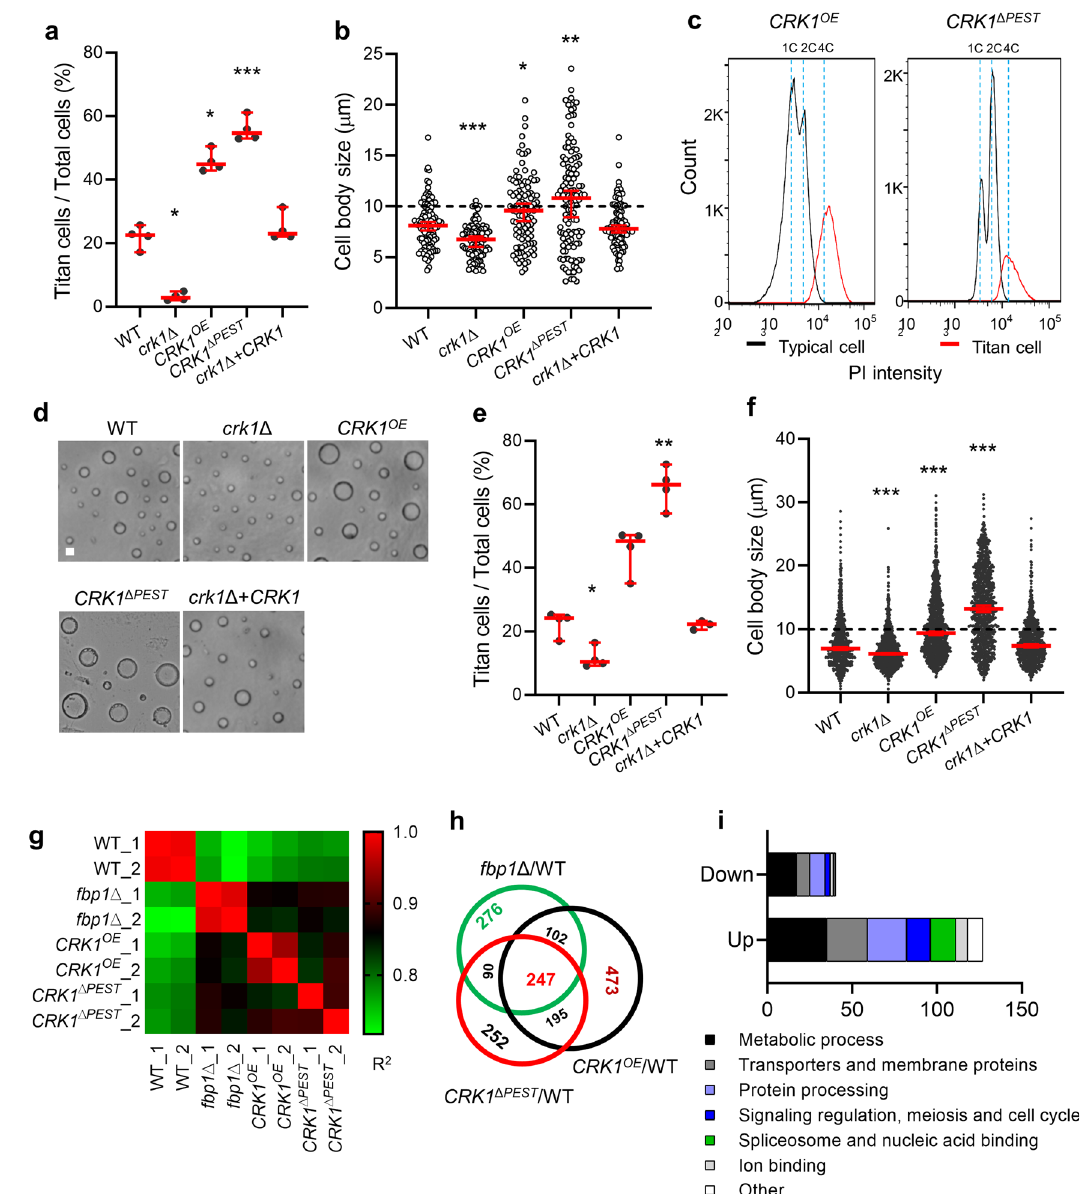
Fig. 3 | Deletion of Fbp1 increases the proportion of titan cells through Crk1 protein accumulation. a , b Quantitative measurement of titan cell proportion ( a ) and cell size ( b ) under in vitro titan cell inducing conditions. The titan cell per- centage data are cumulative from four independent experiments and the cell size data ( n =100 cells) are representative of four independent experiments. Error bar indicates95%con fi denceintervalof themedian. Statistical analysis wasperformed with the two-sided Kruskal-Wallis nonparametric test for multiple comparisons. * P =0.05; 0.03; *** P =0.0004 in panel ( a ). * P =0.01; ** P =0.001; *** P <0.0001 in panel ( b ). c FACS analysis of DNA content in the CRK1 OE and the CRK1 Δ PEST strains. Cells were fi xed and stained by propidium iodide (PI) after 3 days of incubation in titan cell inducing conditions. The population of large cells showed increased PI fl uorescenceintensityto>2C,whilethecellsoftypicalsizepopulationharbored1C or2CPIintensity. d RepresentativeimagesofcellsinBALFcollectedfromamouse infectedwithWT, crk1 Δ , CRK1 OE , CRK1 Δ PEST ,or a crk1 Δ + CRK1 strainafter3days post- infection.Bar,10 µ m. e , f Titancellpercentage( e )andcellsize( f )inBALF.Thedata shown for titan cell percentage are cumulative from four miceand the data shown for cell size are cumulative from 1500 cells. Error bar indicates 95% con fi dence